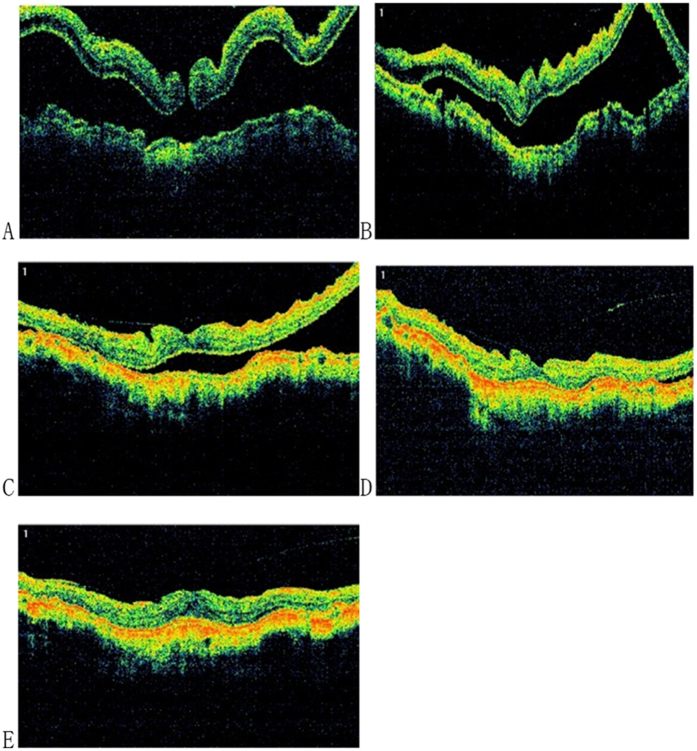
The patient’s left eye received posterior scleral contraction (PSC) in June 2013, the genipin-cross-linked sclera was spindle shaped, and the length of the sclera strip was 45 mm with a width of 12 mm in the middle.(A) One week after the surgery, significant retinal folds were noted, and the macular hole was still present. The axial length (AL) was 27.09 mm with a reduction of 2.90 mm compared to the preoperative AL (29.99 mm), and the LogMAR BCVA was 1.30. (B) One month after the surgery, the retinal detachment area was reduced, the AL was 27.47 mm, and the logMAR BCVA was 1.0. (C) Six months after the surgery, the retinal detachment area continued to reduce, retinal folds were relieved, the AL was 27.78 mm, and the logMAR BCVA was 1.0. (D) Twelve months after the surgery, the retina was essentially reattached, the AL was 27.83 mm, and the logMAR BCVA was 1.0. (D) Twenty-four months after surgery, the retina was completely reattached, the AL was 27.78 mm with a reduction of 2.21 mm compared to the preoperative AL (29.99 mm), and the logMAR BCVA was 0.7.